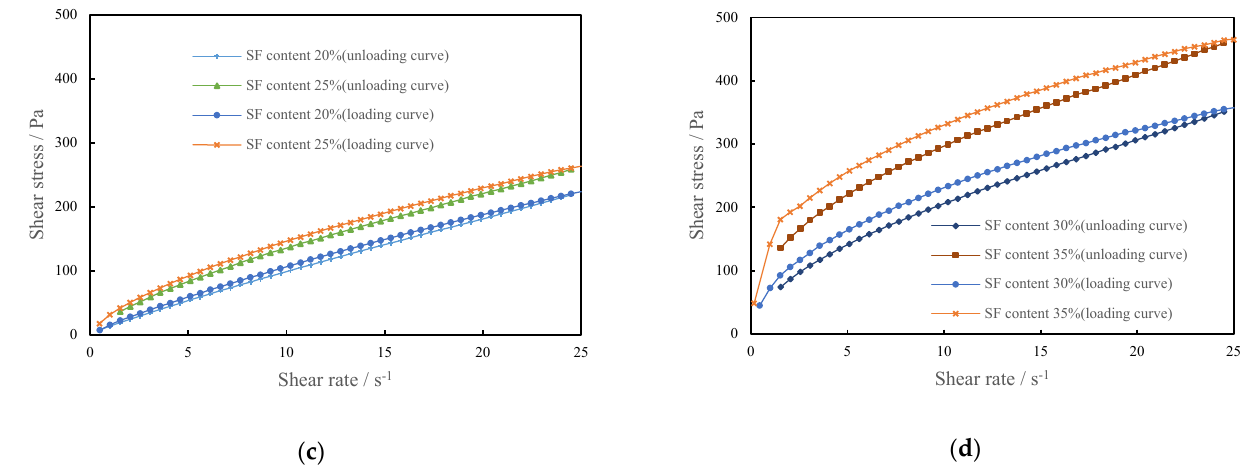
Figure 4. The rheological curve of CSHWMs (W/B = 0.19), ( a ) SF0.19-0% and SF0.19-5, ( b ) SF0.19-10% and SF0.19-15, ( c ) S SF0.19-20 and SF0.19-25, ( d ) SF0.19-30 and SF0.19-35.